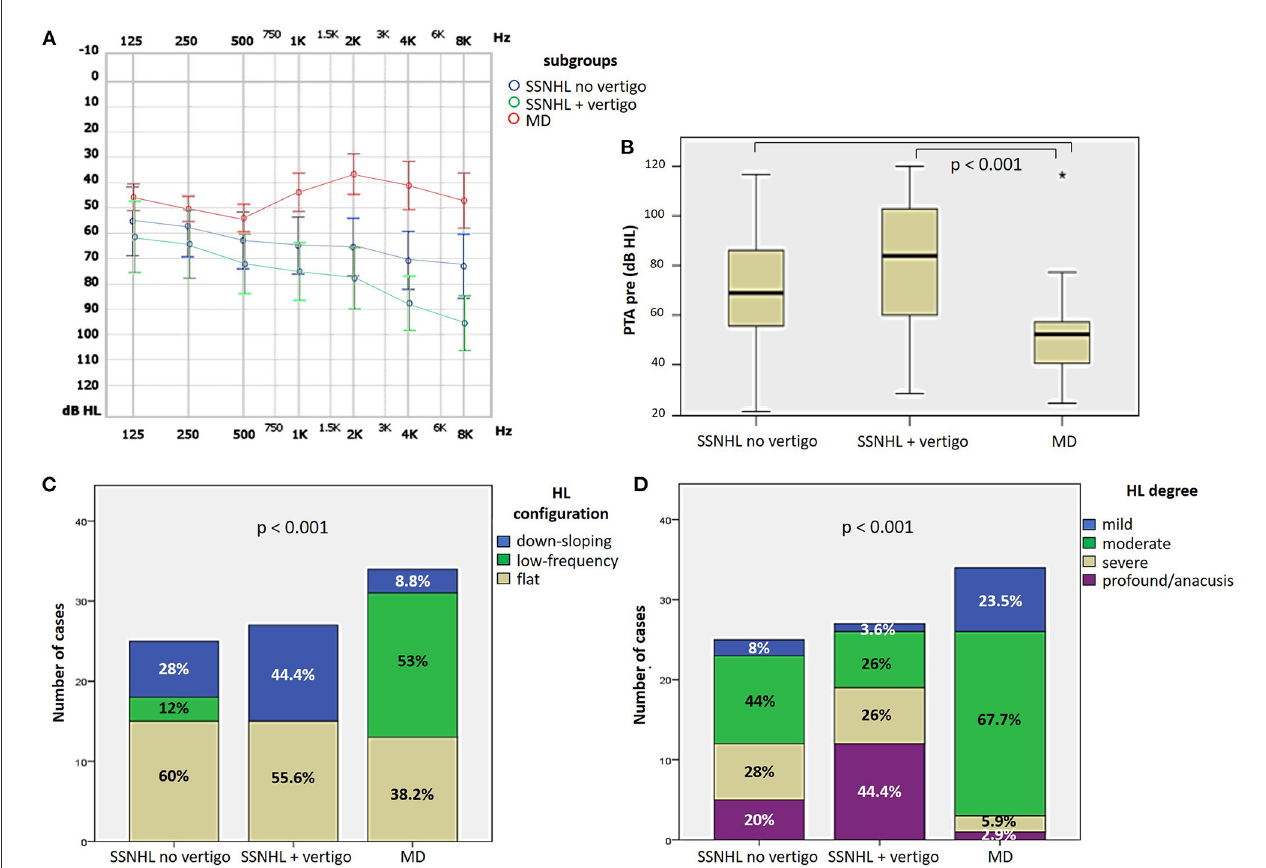
FIGURE2 Presenting audiometric features of the affected ear of the overall cohort, divided in subgroups based on clinical course. (A) Audiogram. (B) Box plot correlating median values of PTA among subgroups. Statistically significant differences at the ANOVA test are shown. (C, D) Bar plots showing the number of cases presenting with different HL configurations (C) and different HL degree (D) among subgroups. Relative percentages are reported in each column and p -values of categorical comparisons are reported. HL, hearing loss; MD, Menière’s disease; PTA pre, presenting pure tone average; SSNHL, sudden sensorineural hearing